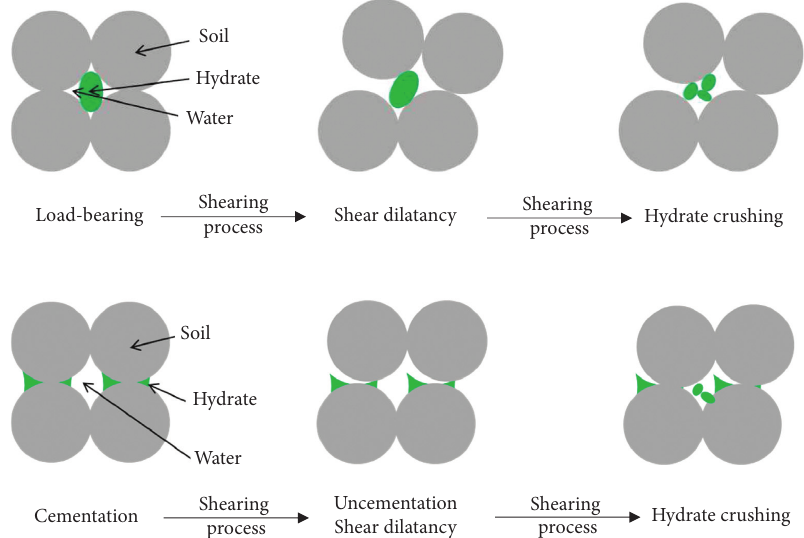
Figure 6: The mechanism for internal structure evolution of hydrate-bearing sediment during shearing [7, 28].